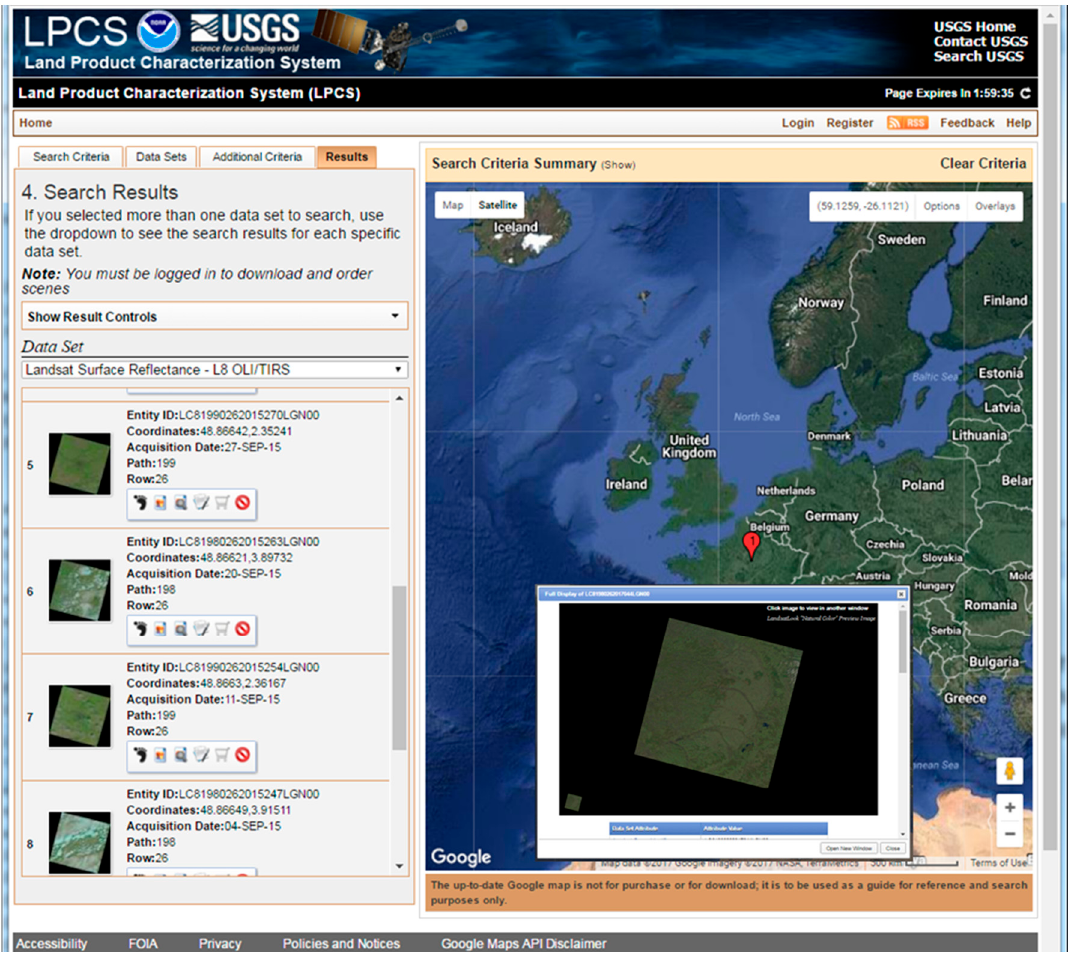
Figure 4. Screenshot of the Results page with an example of an enlarged preview image.